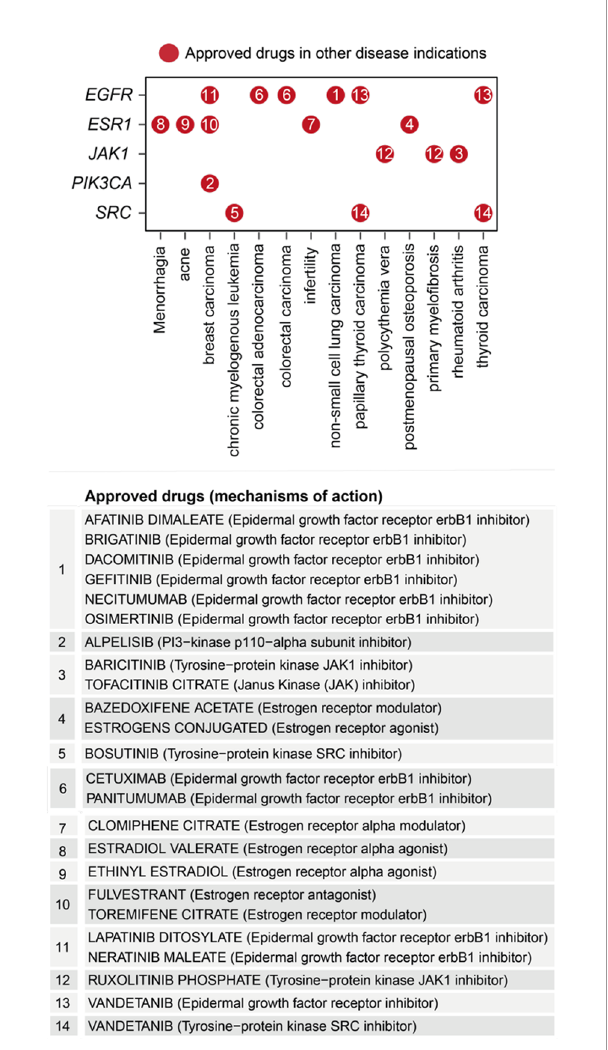
FIGURE 7 | Repurposing analysis of licensed medications based on pathway crosstalk genes. Dot plot shows approved drug target genes (y-axis) and disease indications (x-axis), with dots indexed in number and referenced beneath showing the information on drugs and mechanisms of